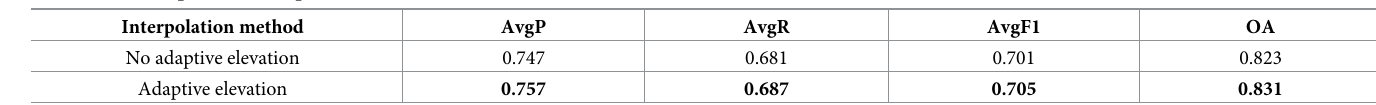
Table 3. The comparison of adaptive elevation.